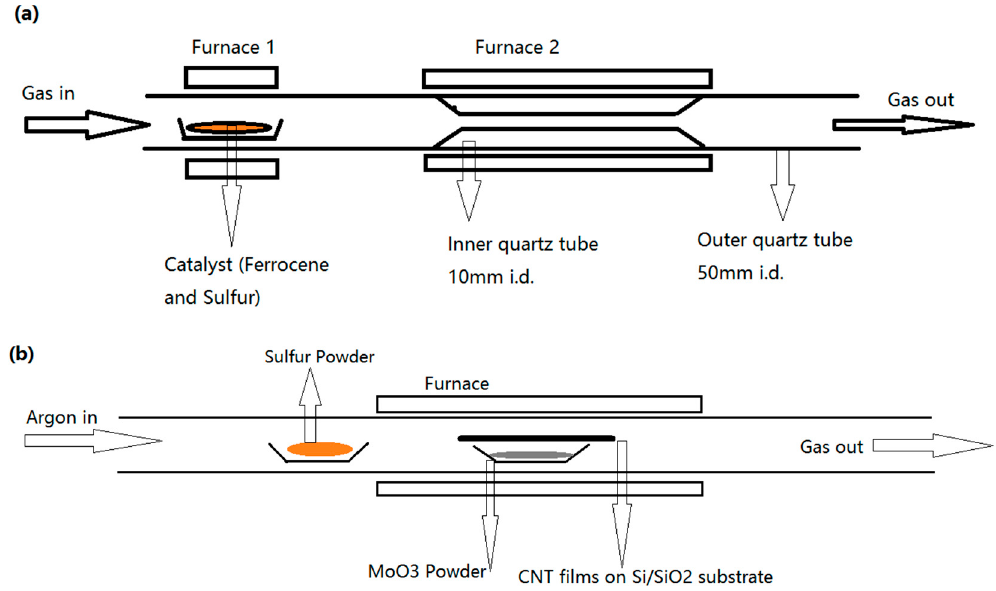
Figure 1. SchematicrouteoftheCVDconfigurationusedtogrow: ( a )CNTfilm; and( b )MoS 2 Figure 1. Schematic route of the CVD configuration used to grow: ( a ) CNT film; and ( b ) MoS 2 @CNT hybrids.